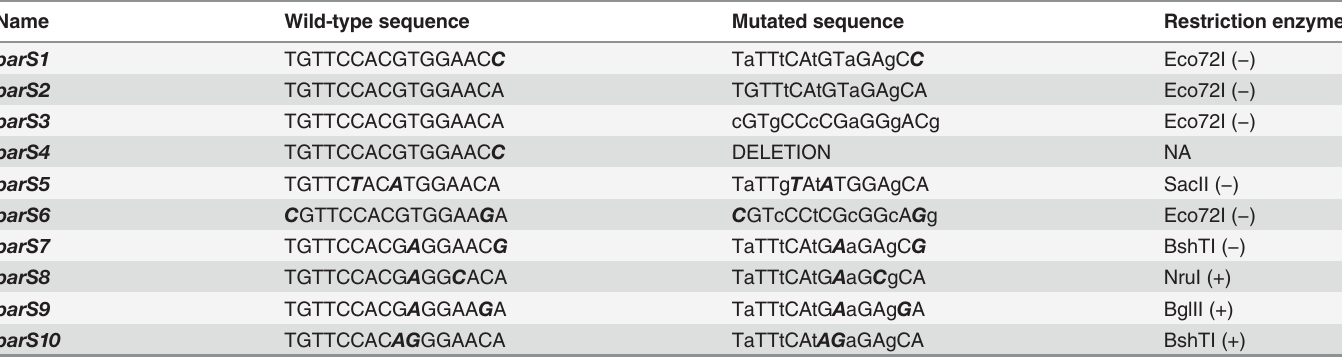
Deviation from the perfect palindrome ( parS2/parS3 ) are indicated in bold italics, and introduced mutations are in lower case. The mutations destroy ( − ) or create (+) a restriction site that was used to distinguish between the wt and mutated sequence. NA — not